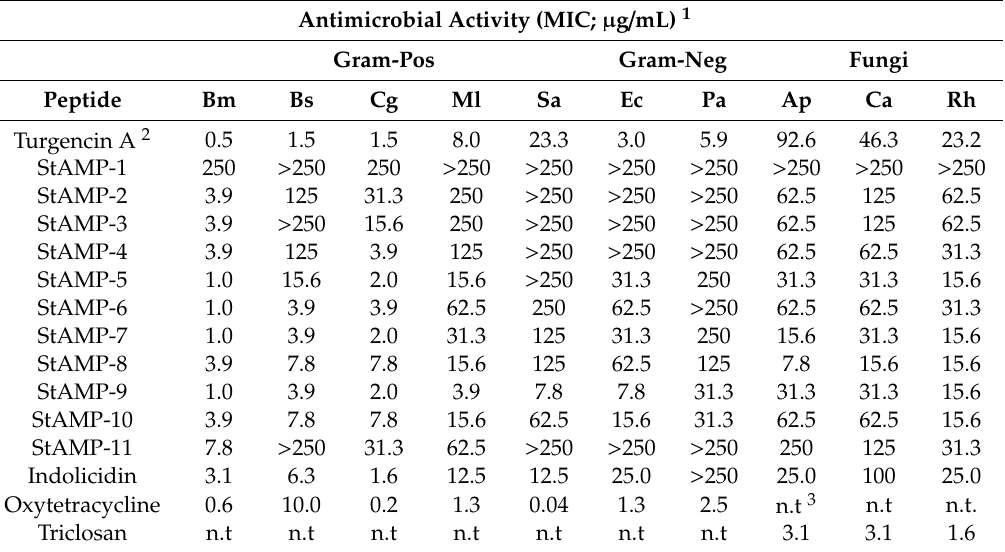
Table 3. Antimicrobial activities of turgencin A and the synthesized StAMP-1–11 peptides. Antimicrobial Activity (MIC; µ g / mL)